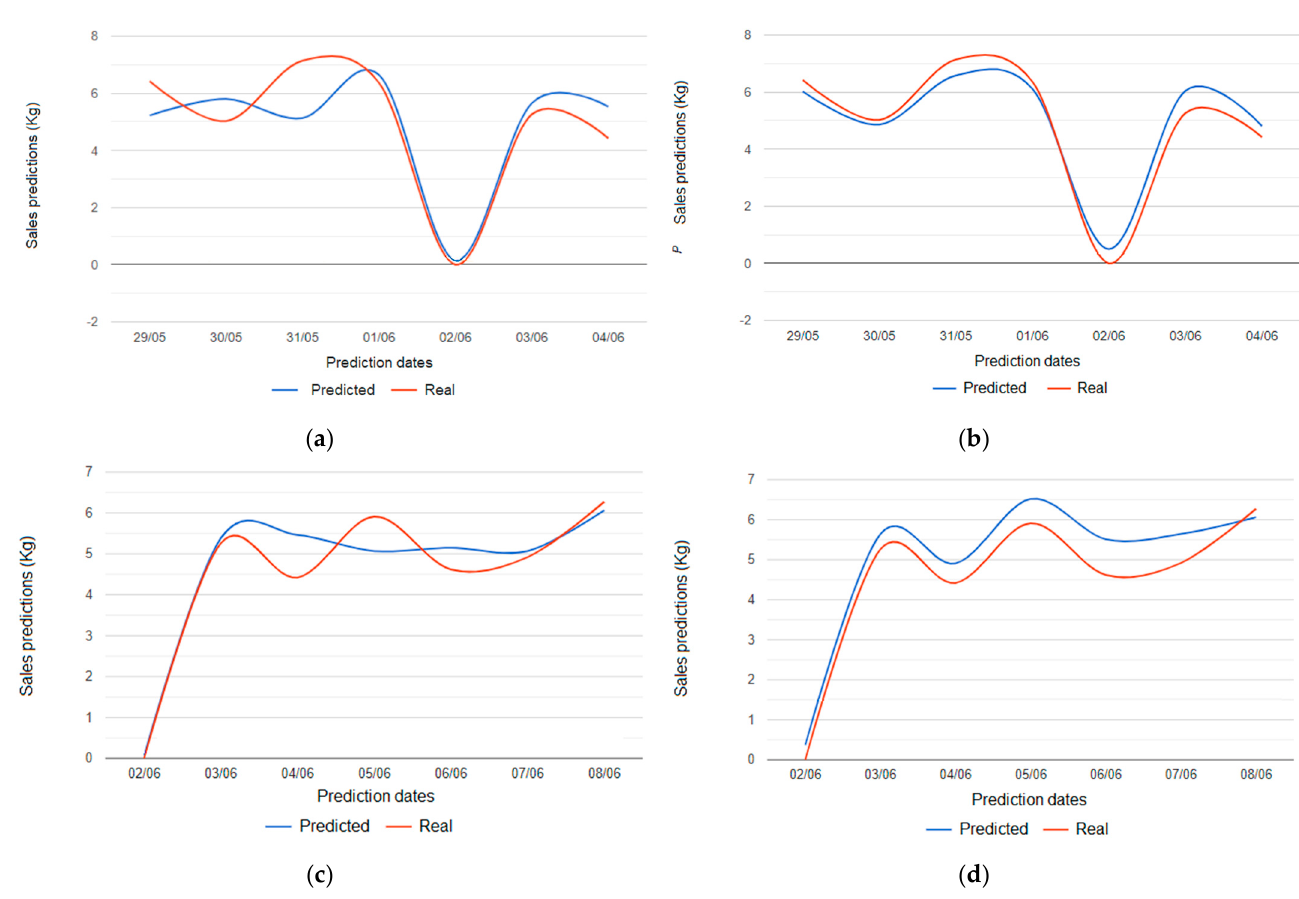
Figure 9. Predictions obtained for a given product for two different time intervals lasting 7 days, compared with the respective cases obtained with the augmented data technique: from 29 May to 4 June with training using the original data ( a ) and the augmented data ( b ); from 2 June to 8 June using the original data ( c ) and the augmented data ( d ).